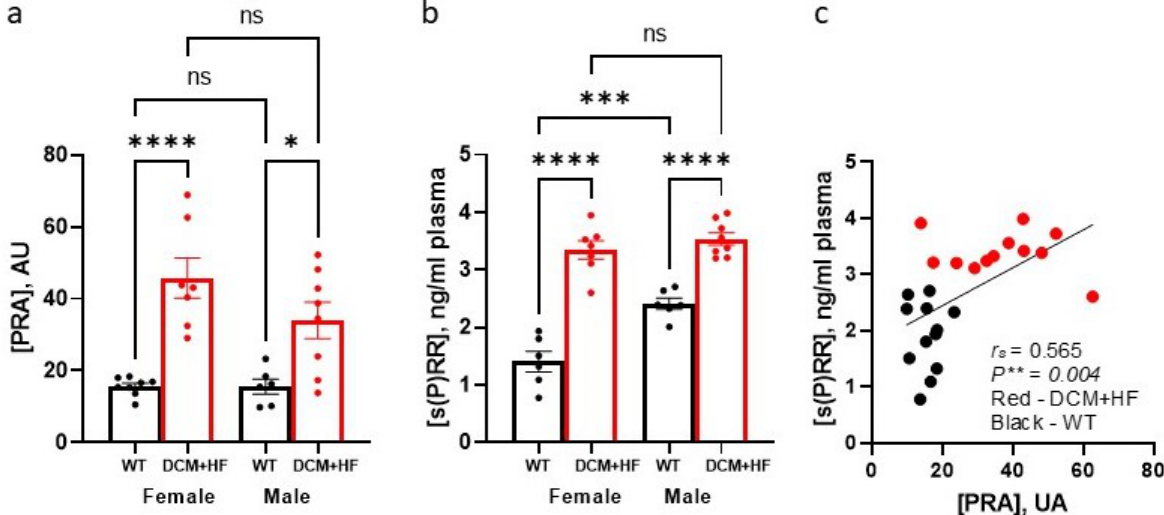
Figure 3. Levels of plasma renin activity (PRA) and soluble (pro)renin receptor (s(P)RR in male and female control mice vs. DCM mice with stage D heart failure: ( a ) levels of PRA; ( b ) plasma levels of (s(P)RR; ( c ) Spearman correlation analysis of combined s(P)RR ( c ) vs. combined PRA. Groups represent female mice with DCM (13 weeks of age, corresponding stage D HF, DCM + HF) and congenic wild-type (WT) mice at 13 weeks of age, and male mice with DCM (20 weeks of age corresponding to stage D HF) and congenic WT at 20 weeks of age. Arbitrary units (AU). Data were analyzed with two-way ANOVA with Tukey’s multiple comparison; * p < 0.05, ** p < 0.01, *** p < 0.001, and **** p < 0.0001; ns—not significant. HF—heart failure; DCM—dilated